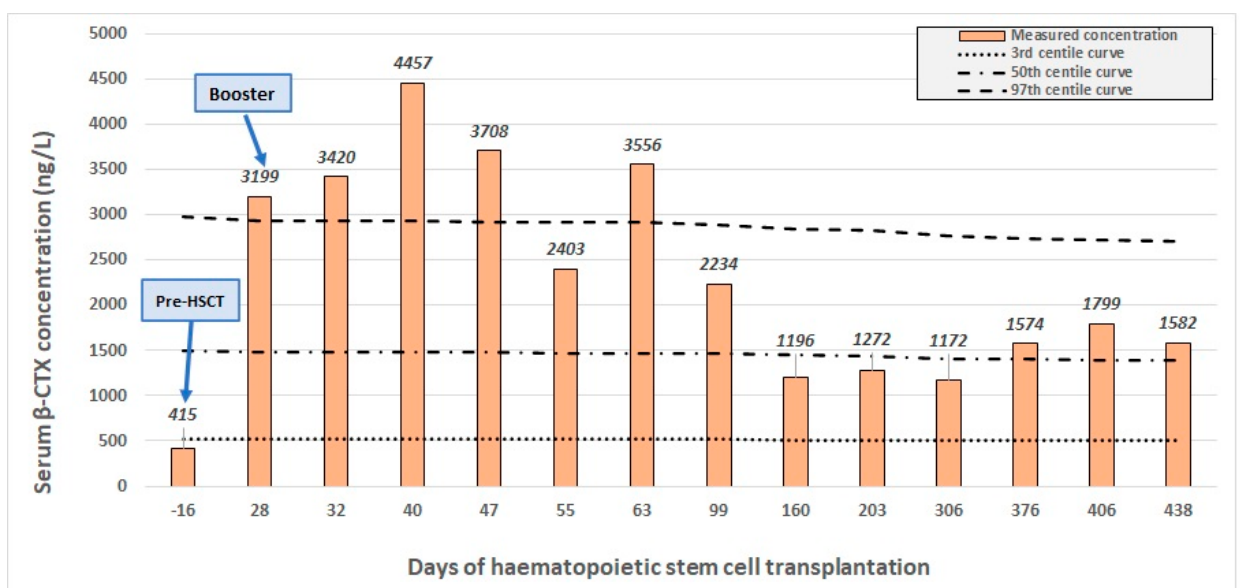
Figure 3. Serum concentration of β -CTX ( β -C-terminal telopeptide) throughout the transplantation. The 97th, 50th, and 3rd centile curves (dotted lines) are shown besides the patient’s own concentration values (columns). Major clinical events: start of conditioning (day –6), HSCT (day 0), engraftment (day 20), booster (day 30), and osteotomy (day 364). Table 1. Parameters of bone metabolism throughout the